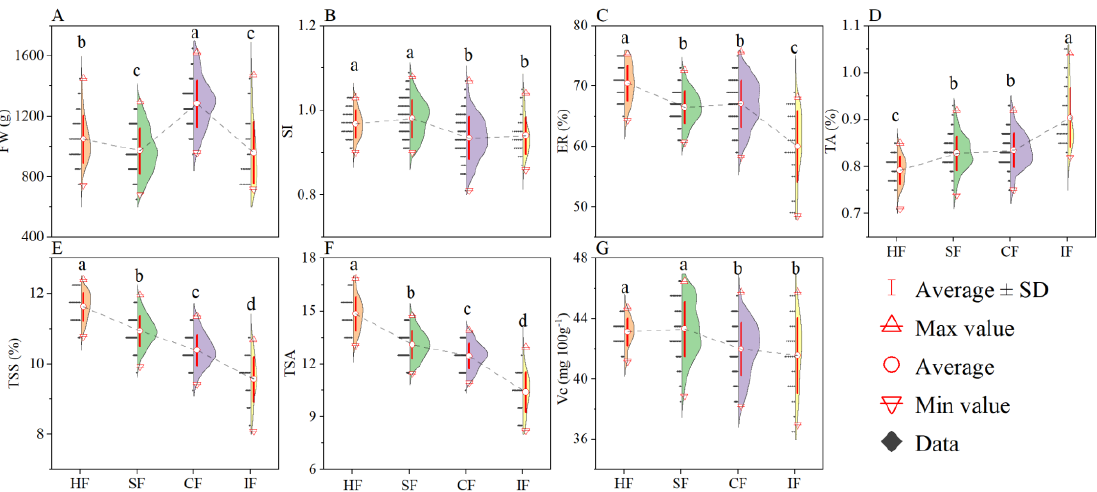
Figure 1. Classification of fruit quality indexes of Guanxi pomelo (Citrus grandis) . HF (47 samples):